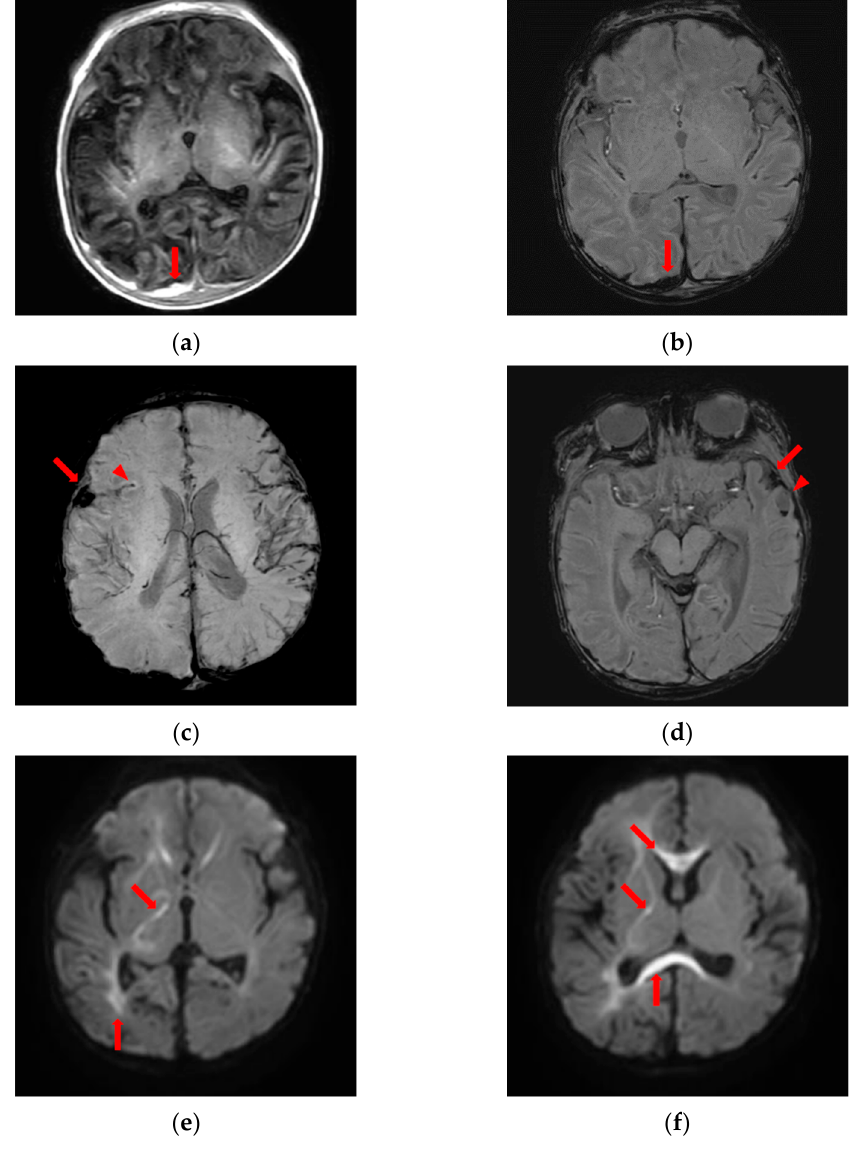
Figure 1. Brain magnetic resonance imaging suggesting abusive head trauma. ( a ) High signal intensity on T1-weighted image and ( b ) low signal intensity on susceptibility-weighted image, subdural fluid collection along the posterior aspect of the falx cerebri and occipital convexity implying subacute subdural hemorrhage (arrows); ( c ) low signal intensity in the right sylvian cistern (arrow), right sylvian fissure (arrowhead) and ( d ) left sylvian cistern (arrow) implying subarachnoid hemorrhage on susceptibility-weighted image; ( d ) low signal intensity with fluid-fluid level (arrowhead) along the anterior side of left temporal lobe implying acute hemorrhage on susceptibility ‐ weighted image; ( e , f ) diffusion restriction in periventricular white matter, corpus callosum, right thalamus, and internal and external capsules on diffusion ‐ weighted image (arrows).